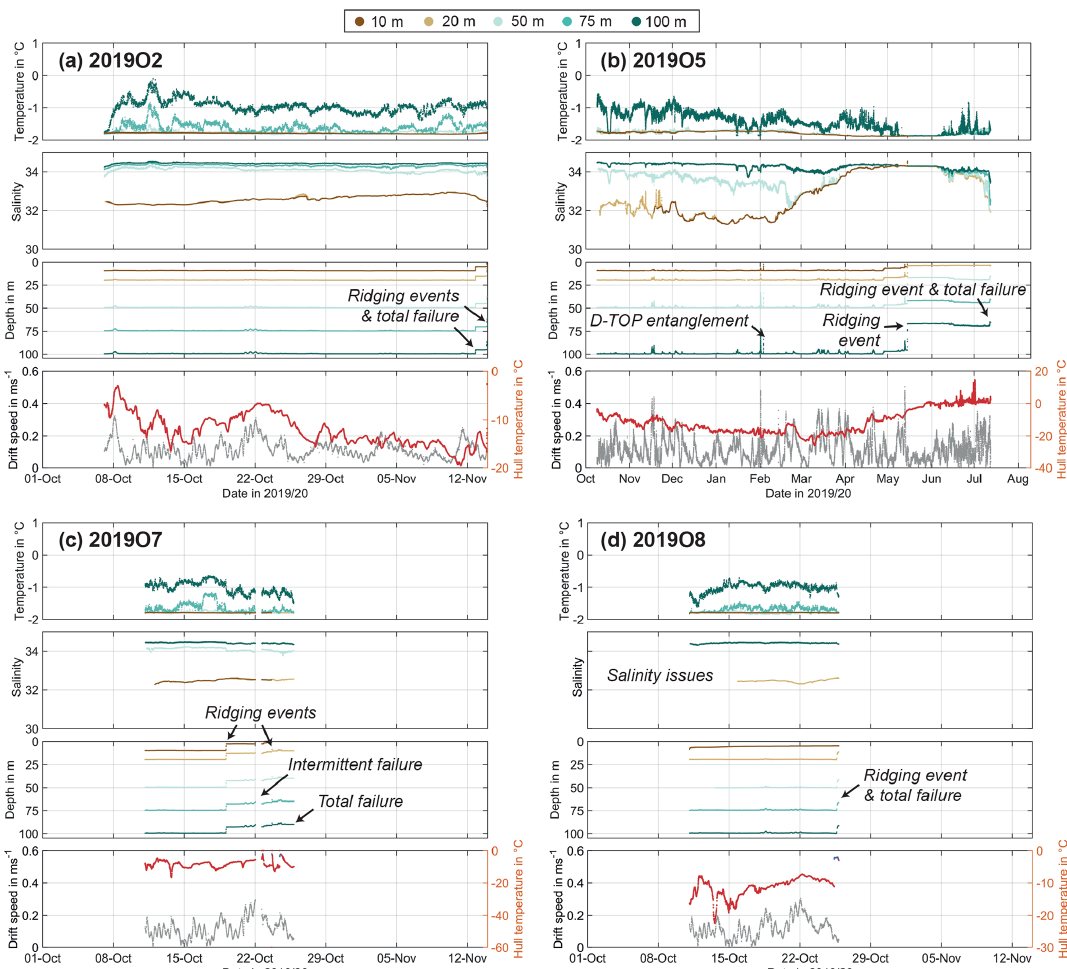
Figure 5. Time series of main variables recorded by buoys for which internal CTD data are not available. (a) 2019O2, (b) 2019O5, (c) 2019O7, and (d) 2019O8. Each of the subplots in panels (a) to (d) show seawater temperature (ITS-90), seawater practical salinity (PSS-78), instrument depth, buoy drift speed (gray), and surface temperature (blue indicates submerged in seawater, and red indicates not submerged). For the oceanographic variables, we only show “1 – good” and “2 – modified”